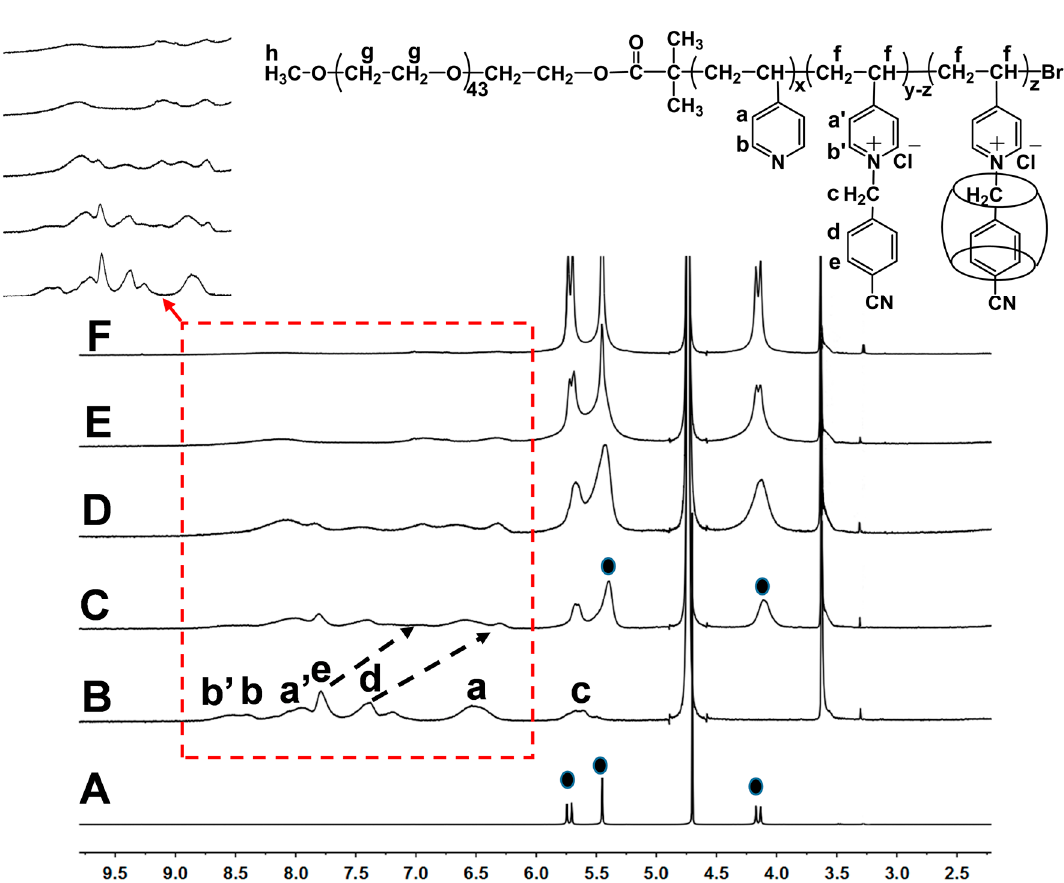
Figure 1. 1 H NMR spectra of CB[7] ( A ), partial 1 H NMR spectra of mPEG- b -QP4VP alone (2 mM in D 2 O) ( B ) and after the addition of 0.25 ( C ), 0.50 ( D ), 1.0 ( E ), and 2.0 ( F ) equiv CB[7]. CB[7] is indicated by black dots.